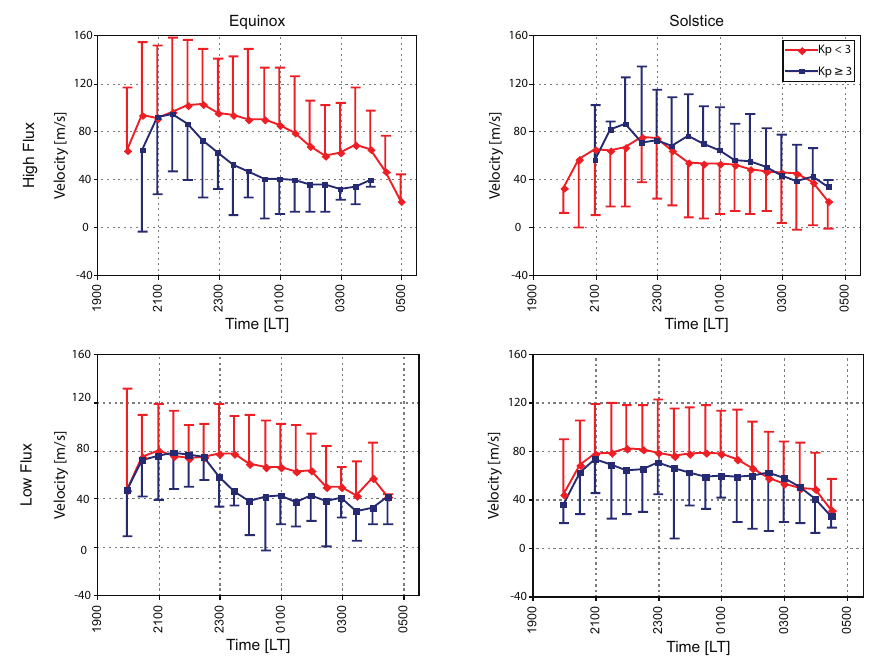
Fig. 4. Zonal drift velocities divided by season, solar flux, and geomagnetic index. In this figure the combined equinox averages are presented on the left side and the June solstice averages are presented on the right side. The upper two graphs represent averages for which the F 10 . 7 index was greater than or equal to 140, while the lower two graphs represent averages for which the F 10 . 7 index was less than 140. Velocities during geomagnetically disturbed conditions are plotted using blue lines and quiet time averages are plotted using red lines.